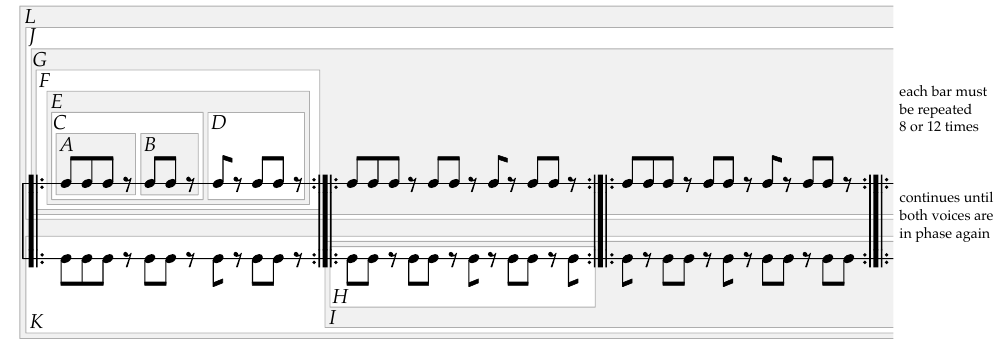
Figure 12. Complete score of S. Reich’s Clapping Music . Each box contains nested musical patterns derived from the initial motif A . Derived pattern L embraces the whole piece. This is only one of many possible procedural analyses of this famous